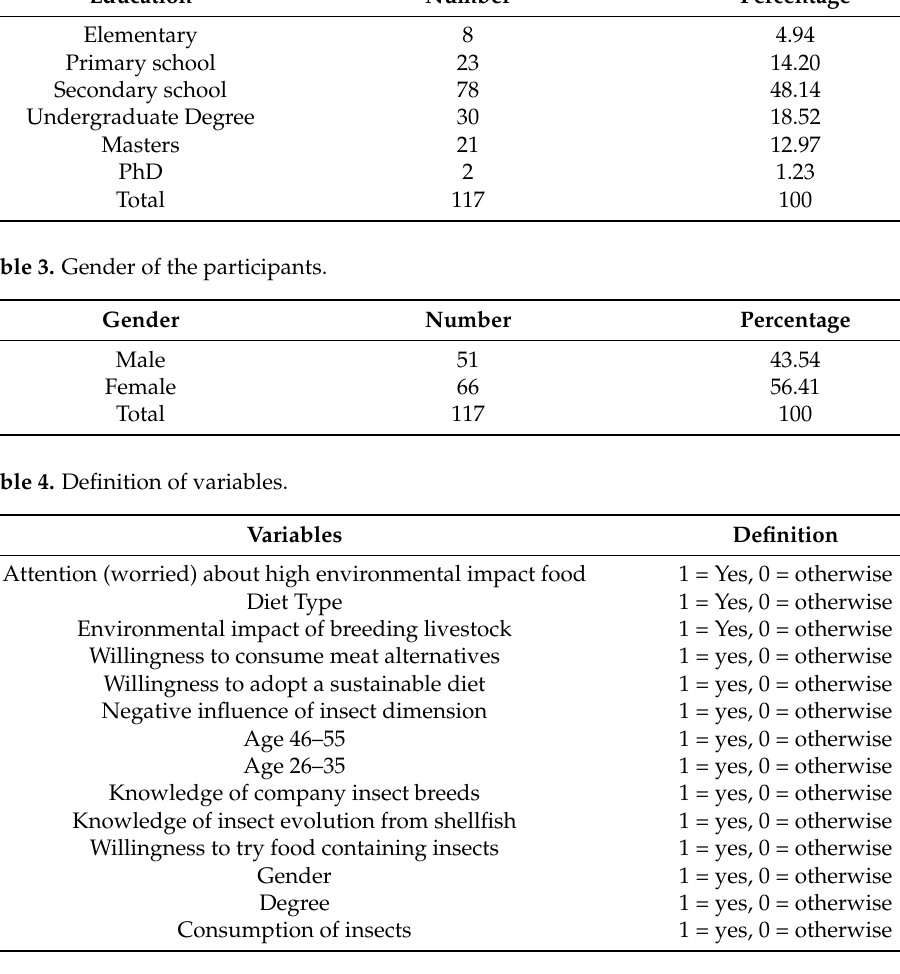
Table 5. Binary probit model results. * p < 0.1; ** p < 0.05; *** p <